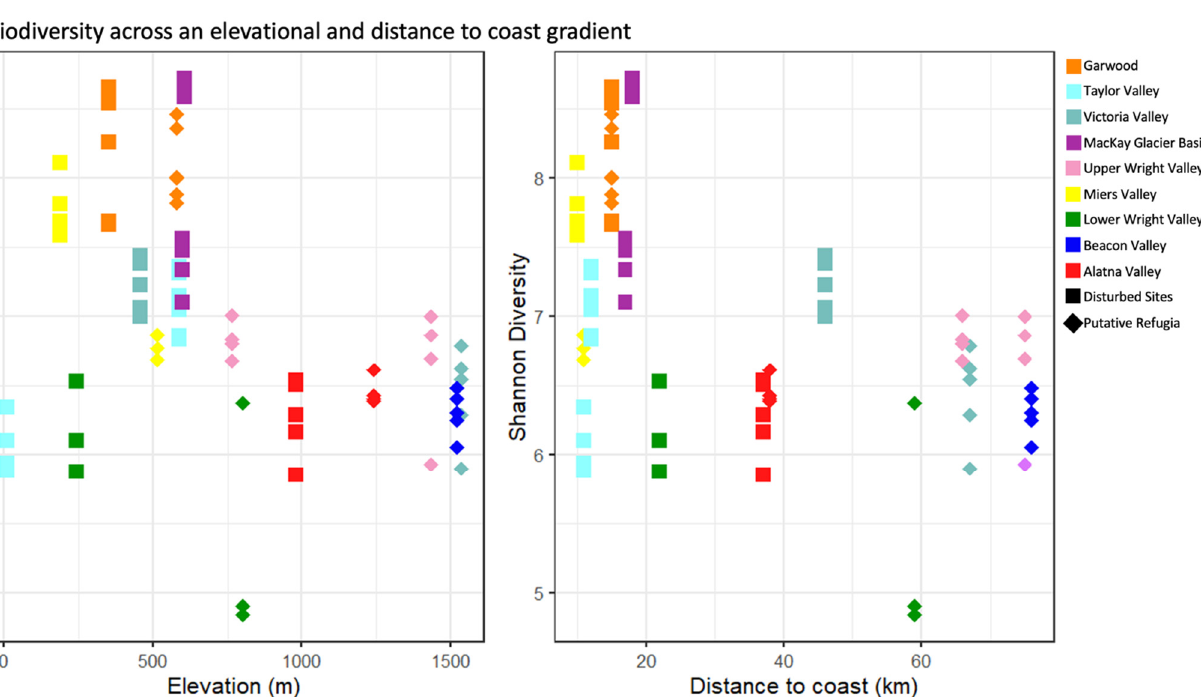
Figure 5. Biodiversity across an elevational and distance to coast gradient. Each individual sample replicates’ Shannon diversity is displayed in relation to the location’s elevation ( left ) and distance to coast ( right ). Diamond shaped points indicate putative refugia and squares indicate disturbed sites, while colors indicate the valley basin of sample origin.